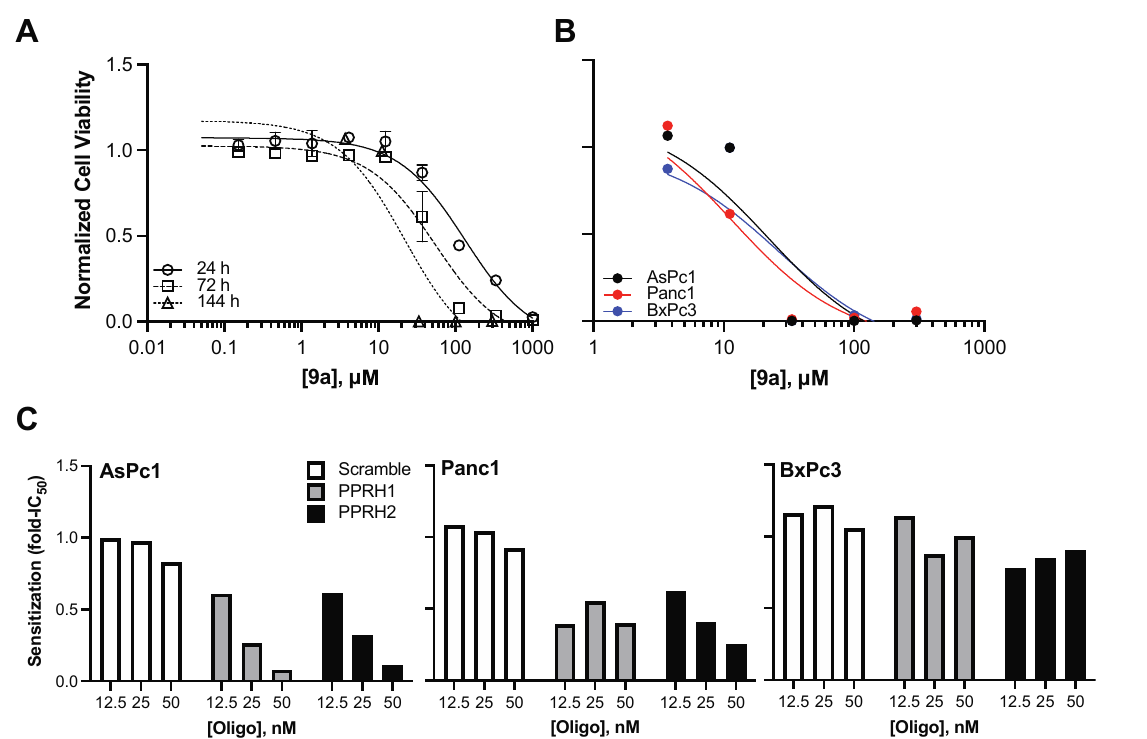
Figure 4. Compound 9a’s intracellular activity and synergy with targeted oligonucleotides. ( A ) AsPc1 cells were treated with a dose-range of compound 9a for the indicated time points to examine the time-dependent effects on cell viability. ( B ) AsPc1, Panc1 and BxPc3 cells were treated with a dose-range of compound 9a for 144 h; no correlation between dose-dependent effects and KRAS-dependency was noted, which indicated compound binding to structures in addition to the KRAS G4 mid (although not the MYC or the KRAS G4 near structures, as already demonstrated). ( C ) The enhancement of compound 9a’s cytoxicity in the presence of PPRH ODNs was examined in the panel of pancreatic cell lines. Compound 9a’s IC 50 s were determined in the absence or presence of the ODNs, and sensitization was calculated as a fold-change in IC 50 (compound 9a’s IC 50 in the presence/absence of the ODN). Dose-dependent sensitization was noted in KRAS–dependent, but not –independent cell lines, with the greatest effects in the highly addicted AsPc1 cells; no sensitization was identified with the scramble control ODN.